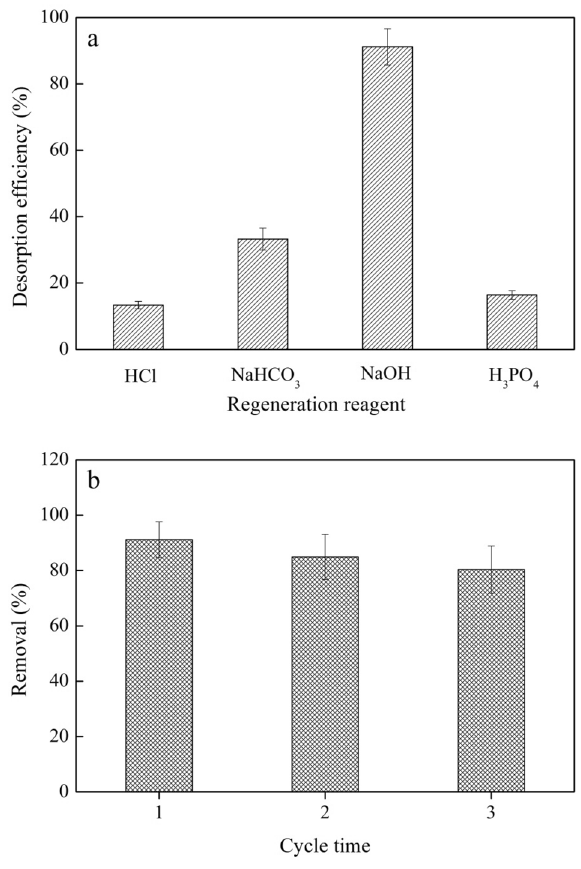
Figure 8. ( a ) Effect of the type of desorption solution on the desorption efficiency and ( b ) regeneration utilization of BMBC with Cr(VI).